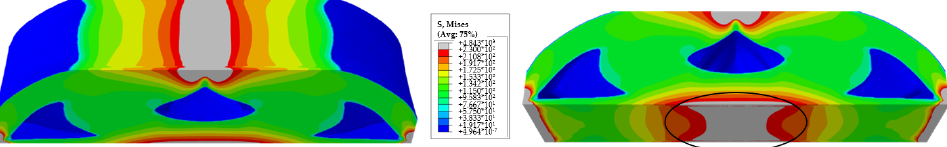
Figure 26. Results of the static FE analysis for the derived design proposal of the standard topology optimization under the boundary conditions of optimization case